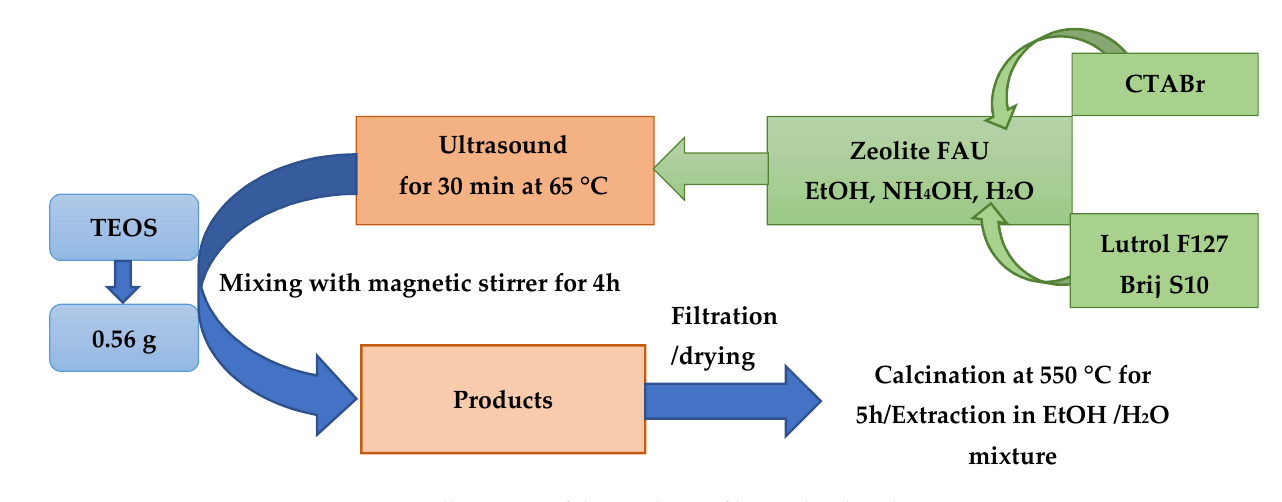
Scheme 1. Illustration of the synthesis of hierarchical zeolites.